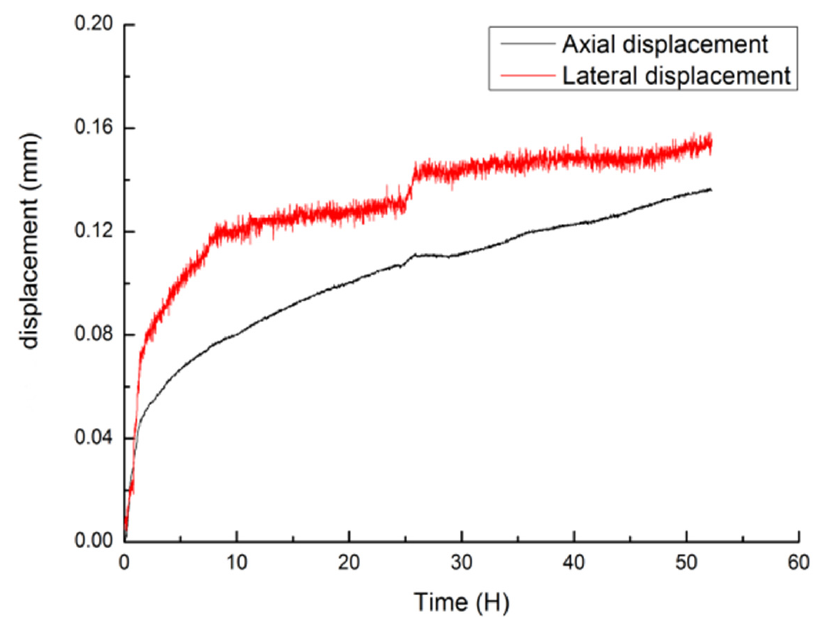
Figure 6. Red shale’s expansion displacement in vertical and lateral direction within sixty hours.